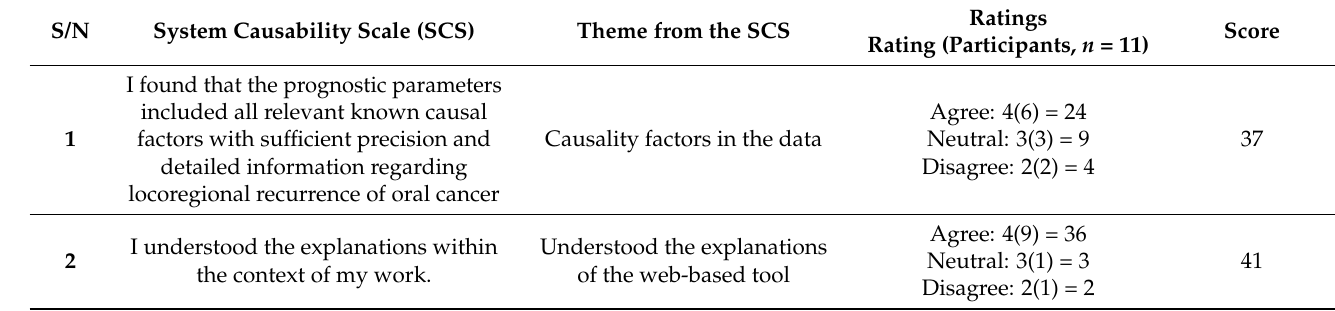
Table 2. Measuring the causality and quality of explanations using the System Causability Scale (SCS) with the Framingham Model